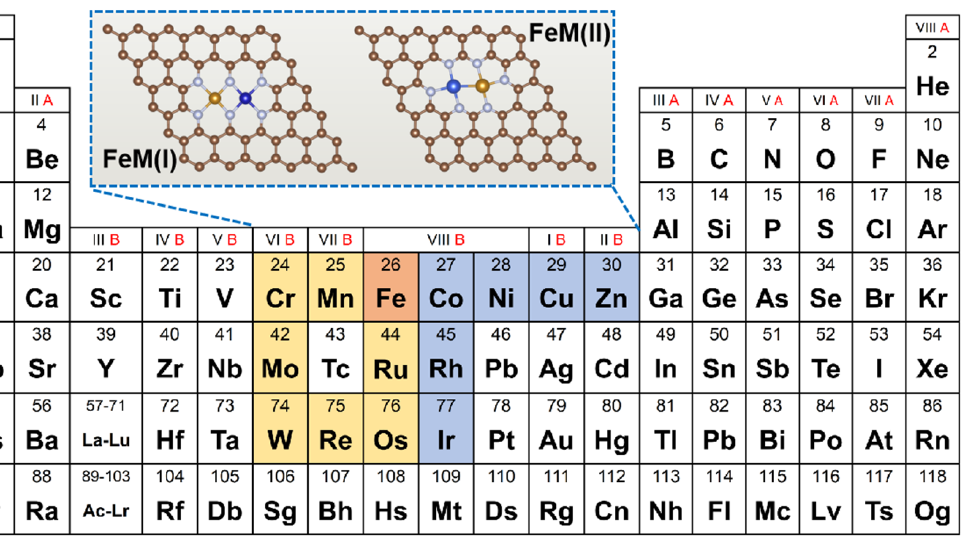
Figure 1. The FeMN 6 with two different N coordination configurations, and the selected M atoms are highlighted with yellow, orange, and blue color in the periodic table. Atomic labels in the insert chemical structures: C (brown), N (lavender), Fe (brown), and M (dark blue). The optimized structures, along with the key reaction intermediates (*O 2 , *OOH, *O and *OH), are depicted in Table S1. For the first H + + e step of ORR, the capture of O